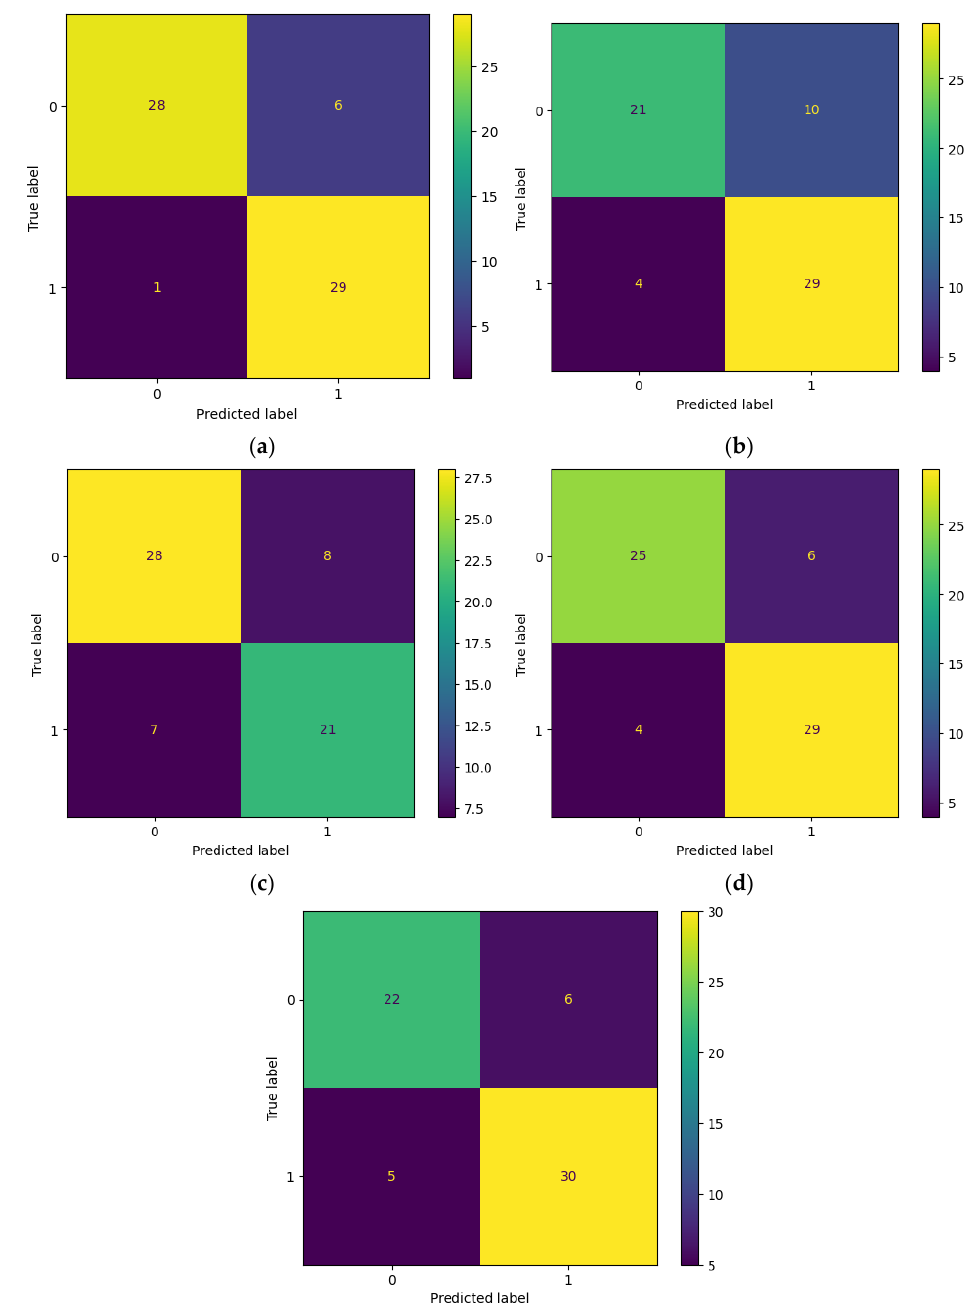
Figure 5. ( a ) Mean and standard deviation of all five folds’ losses per epoch; ( b ) mean and standard deviation of all five folds’ accuracies per epoch.